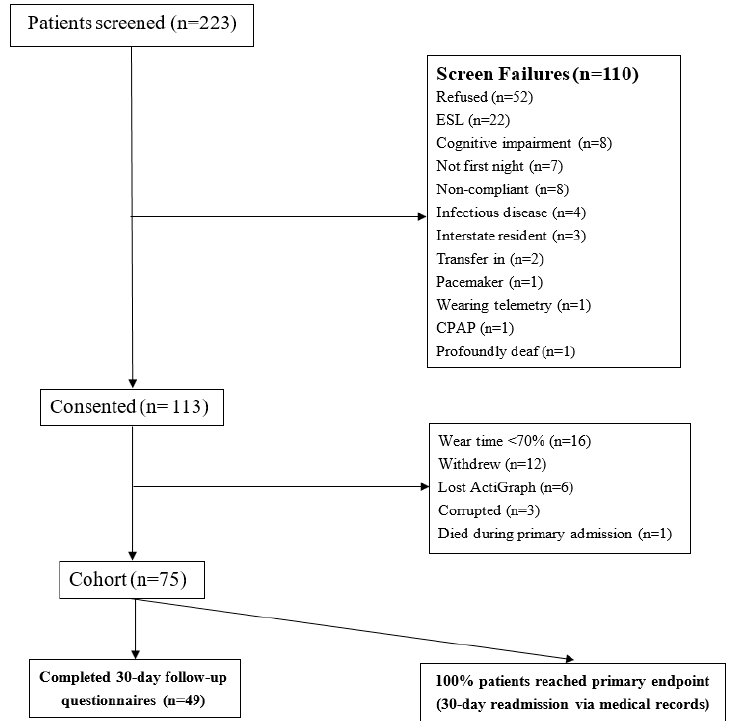
Figure 1. Consort diagram of study cohort. Abbreviations: ESL = English as a second language, CPAP = continuous positive airway pressure.